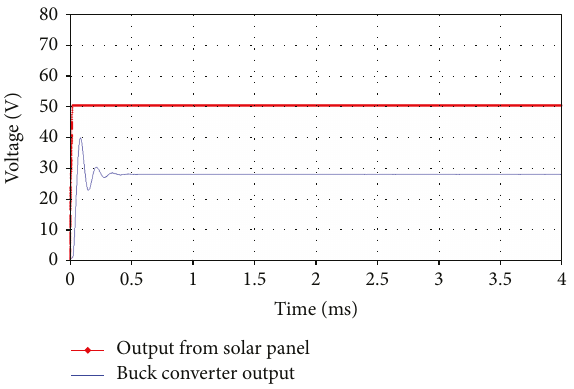
Figure 17: Input and output current waveforms for 41V